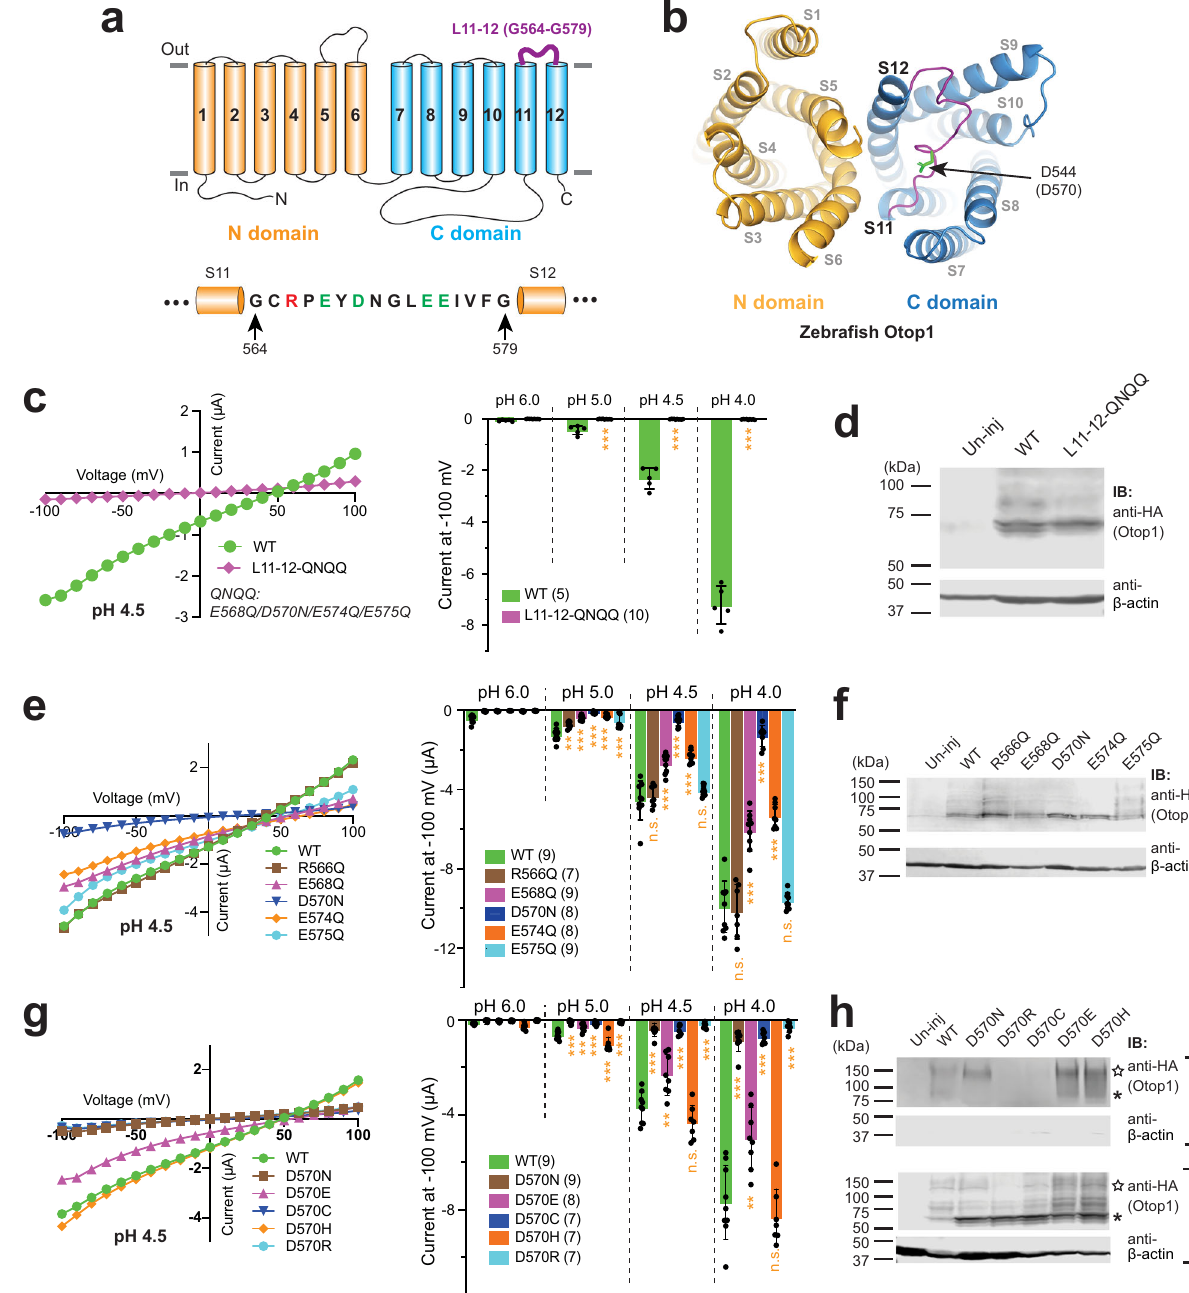
Fig. 5 D570 in L11 – 12 is critical for the function of the Otop1 channel. a Schematic illustration shows the locations of the L11 – 12 in the topology structure of Otop1. The amino acid sequence of the loop is presented at the bottom and the negatively and positively charged residues are in green and red, respectively. b The cryo-EM structure of the zebra fi sh Otop1 (PDB 6NF4) 23 . The S11 – S12 loop, which is in purple, is shown from the top views. The side chain of D544 (corresponding to D570 in human Otop1) is shown as green sticks. c , e , and g Left: the representative I – V curves of the indicated WT and mutant Otop1 channels. Right: the scatter plot and bar graph showing the currents of the indicated channels recorded at − 100 mV at the indicated pHs. Data in the bar graphs are presented as mean ± SD. Currents of the mutants were compared to that of the WT with Student ’ s t -test (* P < 0.05, *** P < 0.001, n.s.: no signi fi cance). Oocyte numbers for scatter plots and bar graphs are indicated in parentheses. Currents in bar graphs are normalized to the mean of the WT currents at pH 4 recorded from the same batch of oocytes. d , f Western blot showing the expression of indicated WT and mutants. h Western blot showing the overall expression (in lysate samples) and surface expression of indicated WT and mutant channels. The surface proteins were puri fi ed by surface biotinylation. The asterisks and stars indicate the monomer and dimer bands of Otop1, respectively.